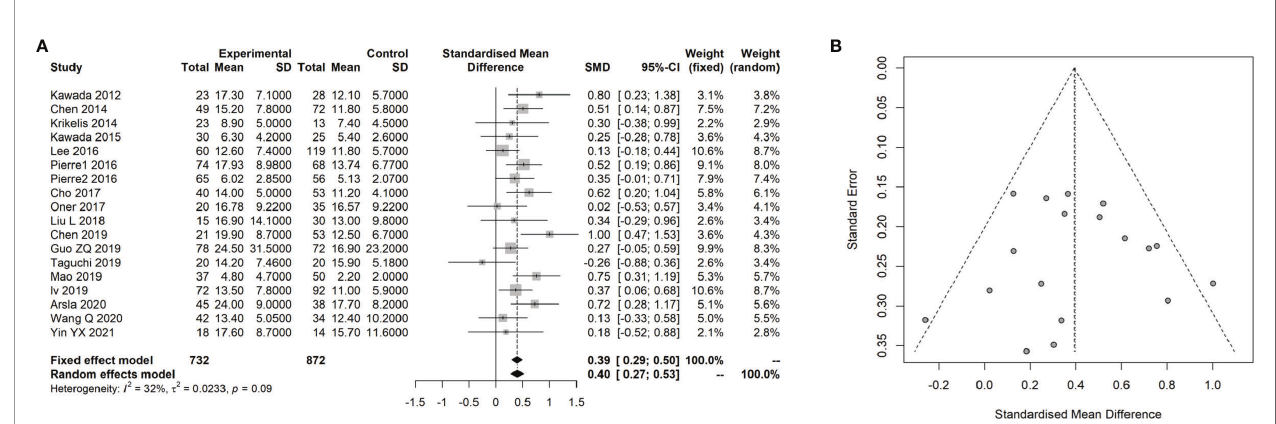
FIGURE 4 | Meta-analysis for the association of SUVmax with KRAS status in CRC cancer. (A) Forest plot for the association of SUVmax with KRAS status. (B) Funnel plot for the publication